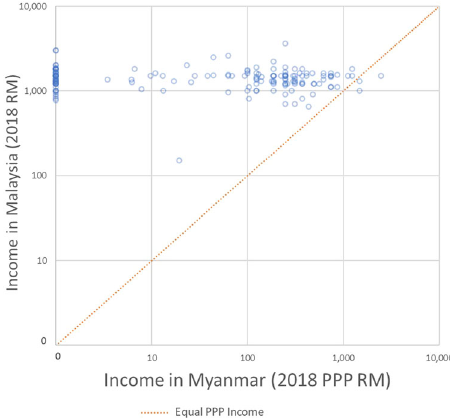
Fig. 8 Income in Malaysia (2018 RM) vs. Income in Myanmar (2018 PPP RM). Scatter plot of income in Malaysia (2018 RM) and income in Myanmar (2018 PPP RM).